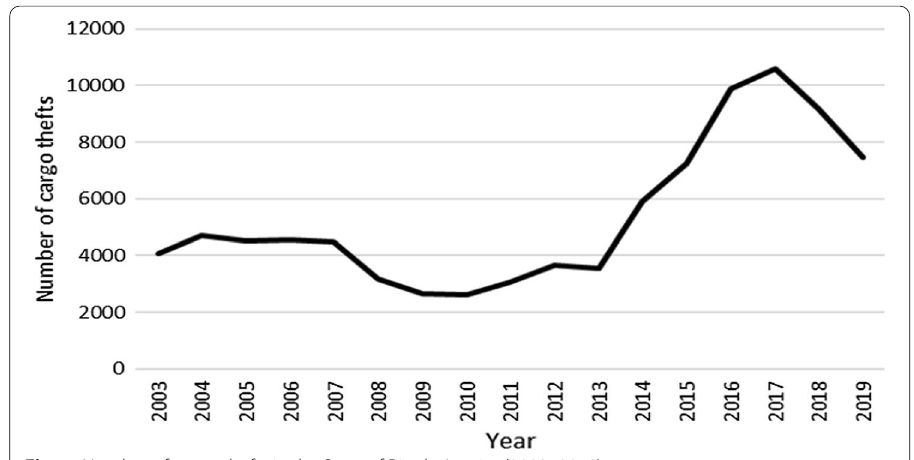
Fig. 5 Number of cargo thefts in the State of Rio de Janeiro